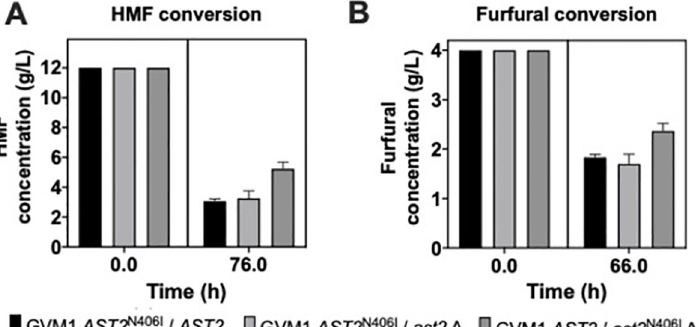
Fig 6. Conversion of HMF and furfural in small-scale fermentations with GVM1 and the hemizygous strains of GVM1 containing either the mutant AST2 N406I allele or the wild-type AST2 allele. Small-scale fermentations (10 mL) were performed at pH 4.6, 35˚C, 350 rpm, initial OD 600 of 5.0 in (A) YPDX with 12 g/L HMF or (B) 4 g/L furfural. Subsequent HPLC analysis of fermentation samples obtained (A) in YPDX with 12 g/L HMF at t = 0h and t = 76h, and (B) in YPDX with 4 g/L furfural at t = 0h and t = 66h, revealed that HMF and furfural concentrations had decreased to a greater extent during the course of fermentation by the strains containing the AST2 N406I allele compared to the strain with the wild-type AST2 allele. Error bars represent standard